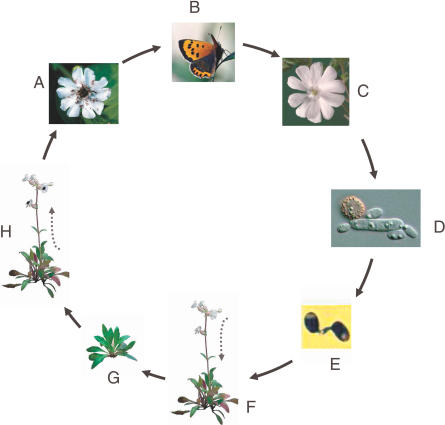
Life Cycle of the Phytopathogenic Fungus M. violaceum
Diploid teliospores are produced in the anthers (A) and are transmitted by pollinators (B) onto a healthy plant (C). The teliospores germinate, undergo meiosis, and produce yeast-like sporidia (D). Conjugation takes place on the plant between sporidia of opposite mating types (E). Dikaryotic hyphae grow in the plant (F) and overwinter in vegetative tissues (G). The following year, infection is systemic (H) and all flowers produce teliospores (A).